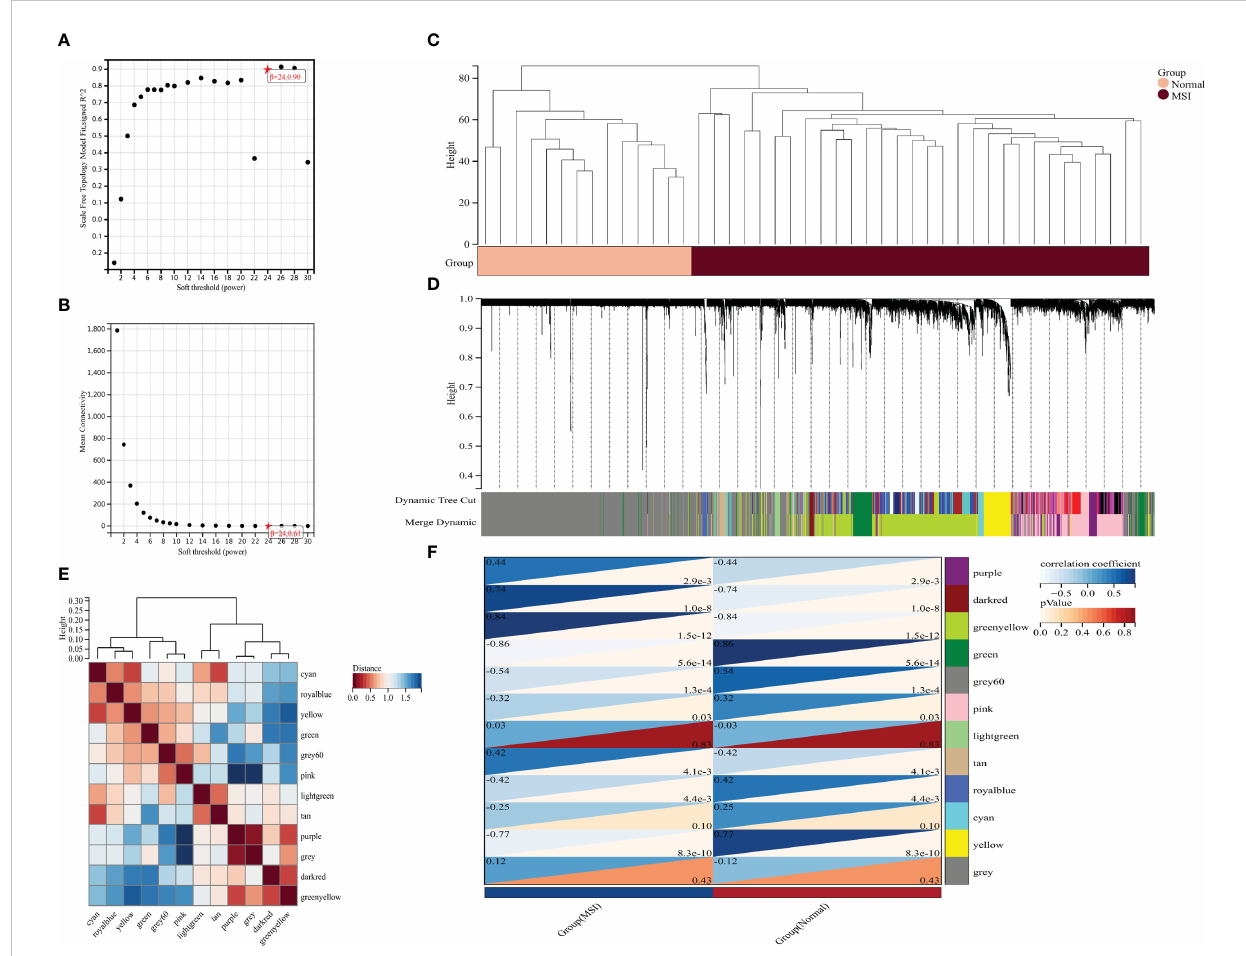
FIGURE 3 Mining potential biomarker genes associated with MSI based on weighted gene networks. (A) scale independence, (B) average connectivity, (C) The sample clustering indicated no outlier samples, (D) gene clustering, (E) module feature vector clustering, and (F) heat map of module and phenotype